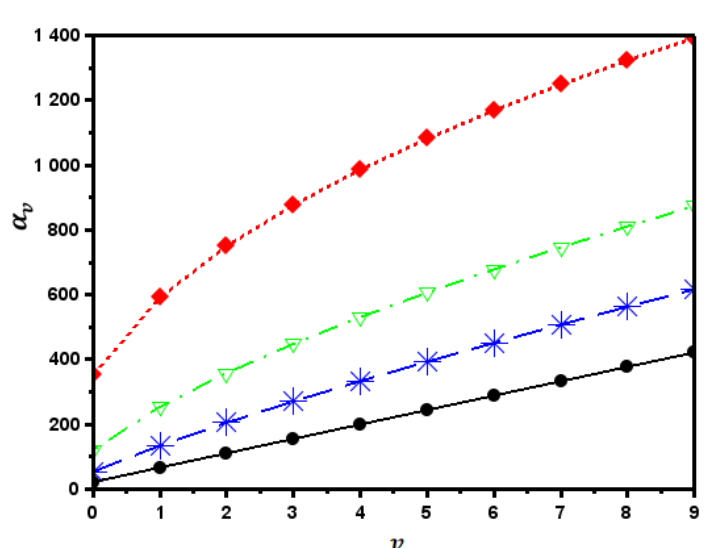
= 10 15 G pm − n , when 0